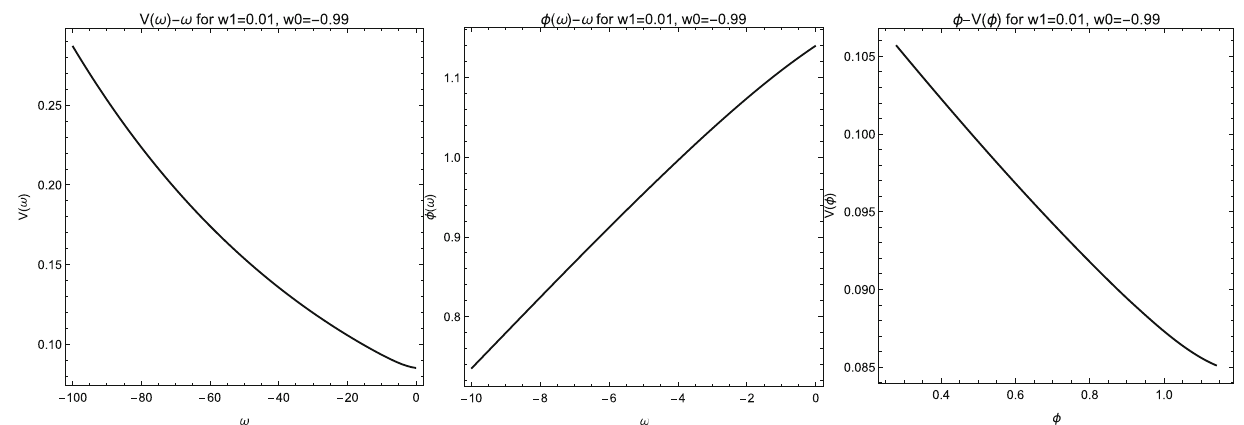
Fig. 4 Qualitative evolution of the scalar field φ (ω), the scalar field potential V (ω) as also the parametric plot φ − V (φ) is given for the Ext2 model